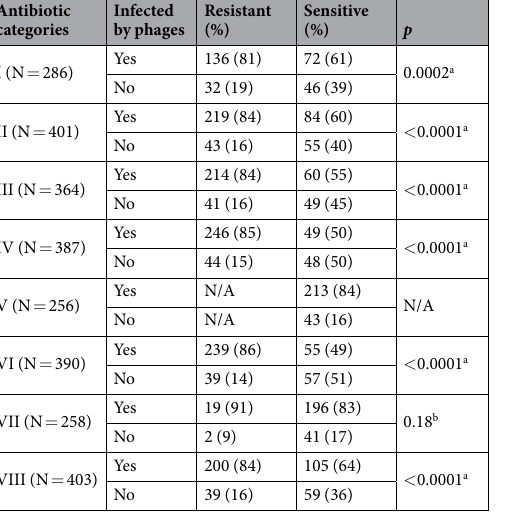
Table 1. Differences in the distributions of phage infection rates between A. baumannii strains showing resistance and sensitivity to the different antibiotic categories. Notes: a Chi-squared test. b Fisher’s exact test. N/A = not available. Resistant = resistant to the respective antibiotic category. Sensitive = sensitive to the respective category. The antibiotic categories are as follows: (I) Aminoglycoside (amikacin and gentamicin), (II) B eta-lactam/beta-lactamase inhibitor combination (tazobactam-piperacillin), (III) Cephalosporin (ceftazidime and cefepime), (IV) Quinolone (ciprofloxacin and levofloxacin), (V) Polymyxin (colistin), (VI) Sulfonamides (baktar), (VII) Tetracycline (tigecycline) and (VIII) Carbapenem (doripenem, imipenem and meropenem).